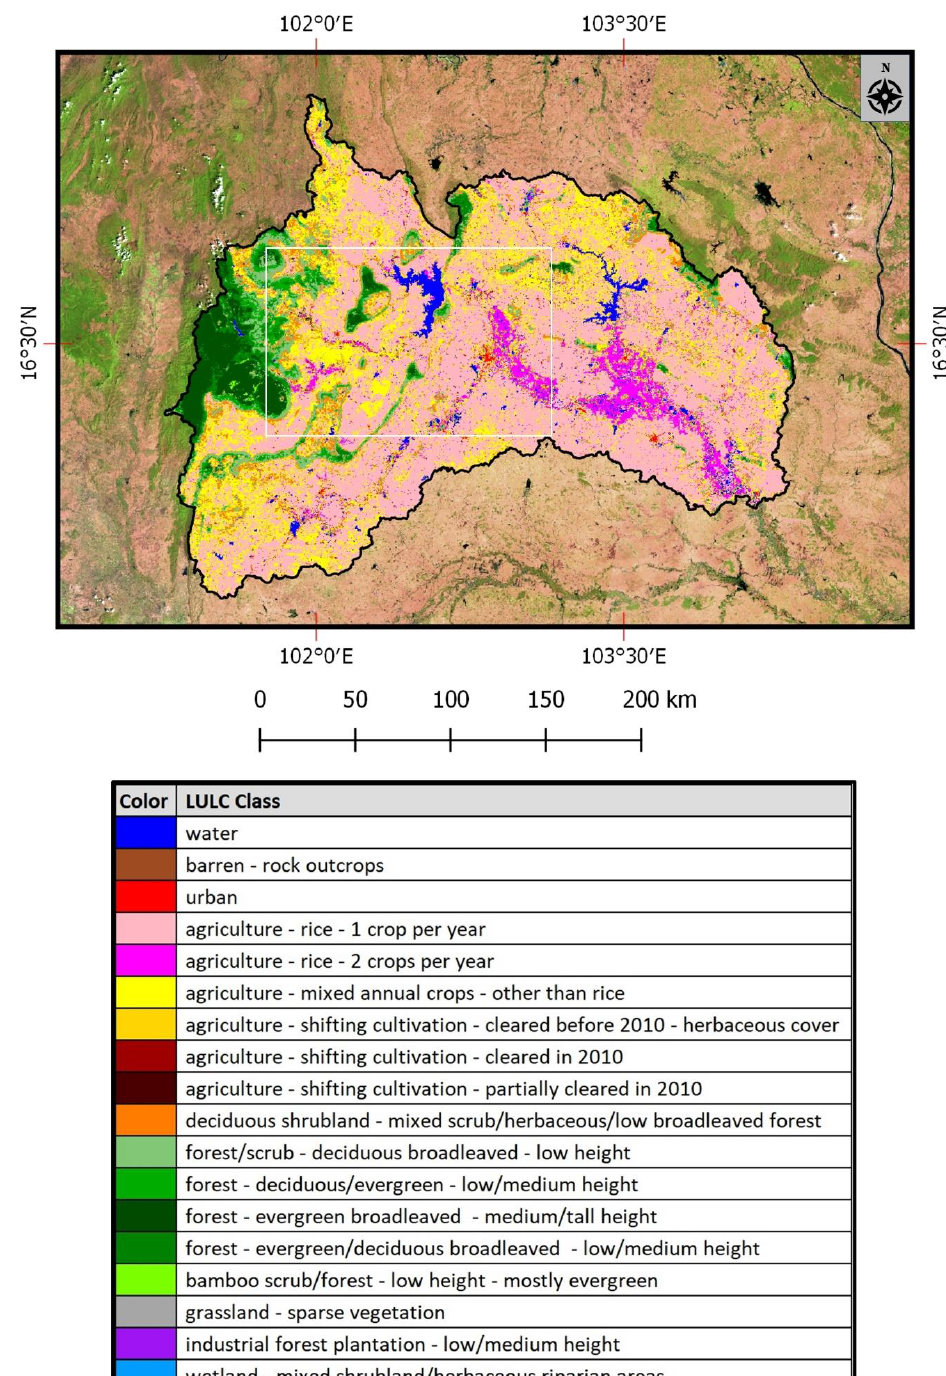
Figure 7. 2010 LULC map of study area produced by project. The study area is outlined in black. The white rectangle shows location of Figure 9.